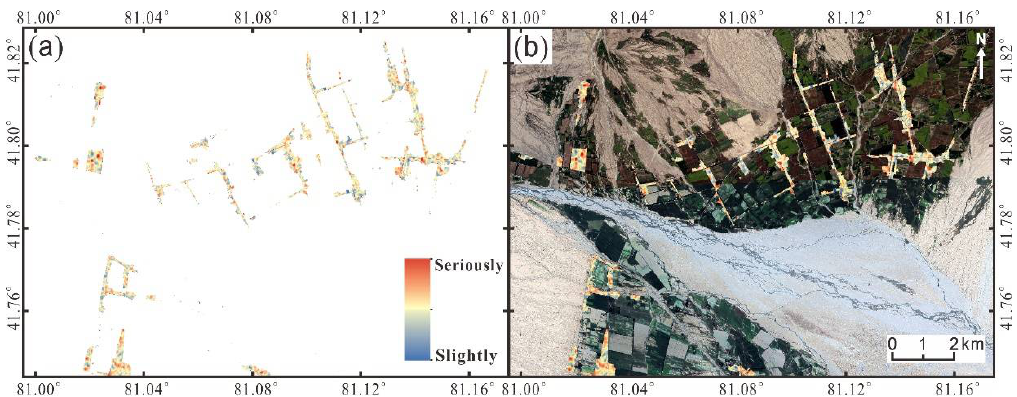
Figure 10. Polarimetric decomposition results. ( a ) Polarization decomposition results of pre-seismic images; ( b ) Polarization decomposition results of coseismic images; ( c ) The corresponding optical image obtained using Google Earth; ( d ) On the basis of Figure 10c, the building area is superimposed in red. Location of the hypocenter, drawn as a white circle.